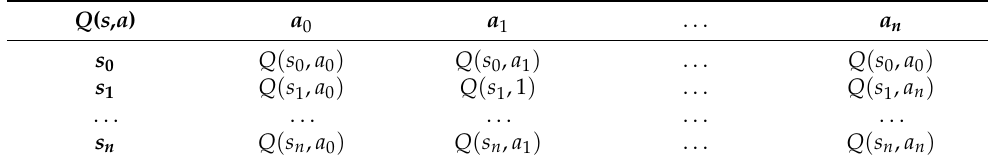
Table 1. Example of